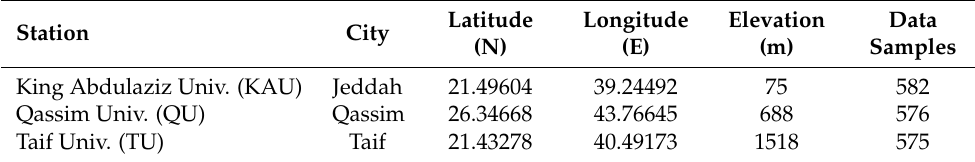
Table 2. The data of the stations and their recorded measurements.